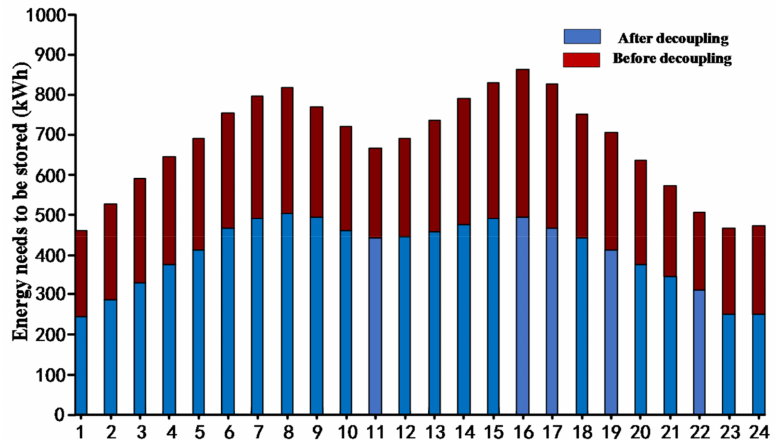
Figure 8. Total electrical energy needs to be stored in the